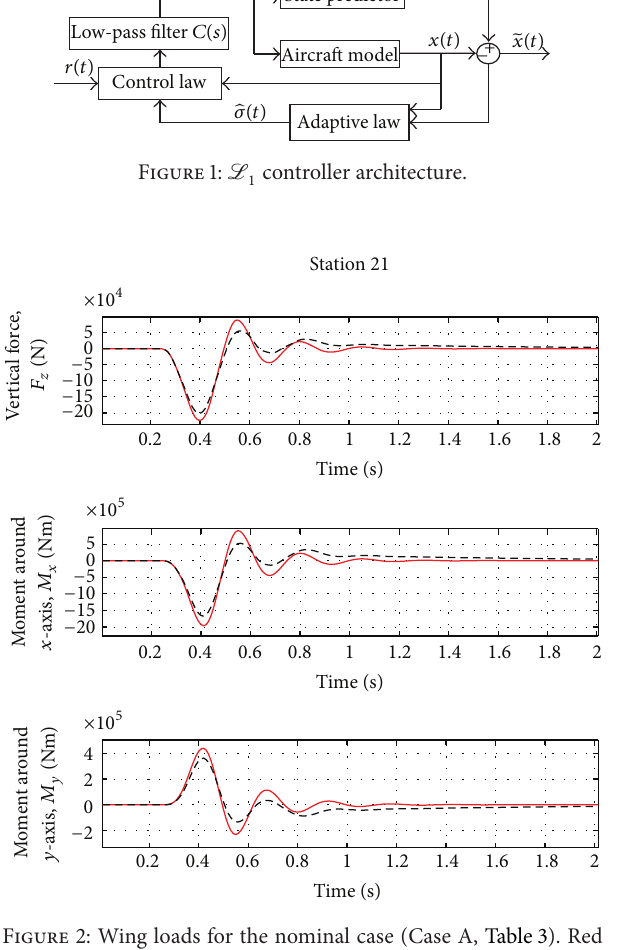
Figure 2: Wing loads for the nominal case (Case A, Table 3). Red solid line: open loop. Black dotted line: closed loop.